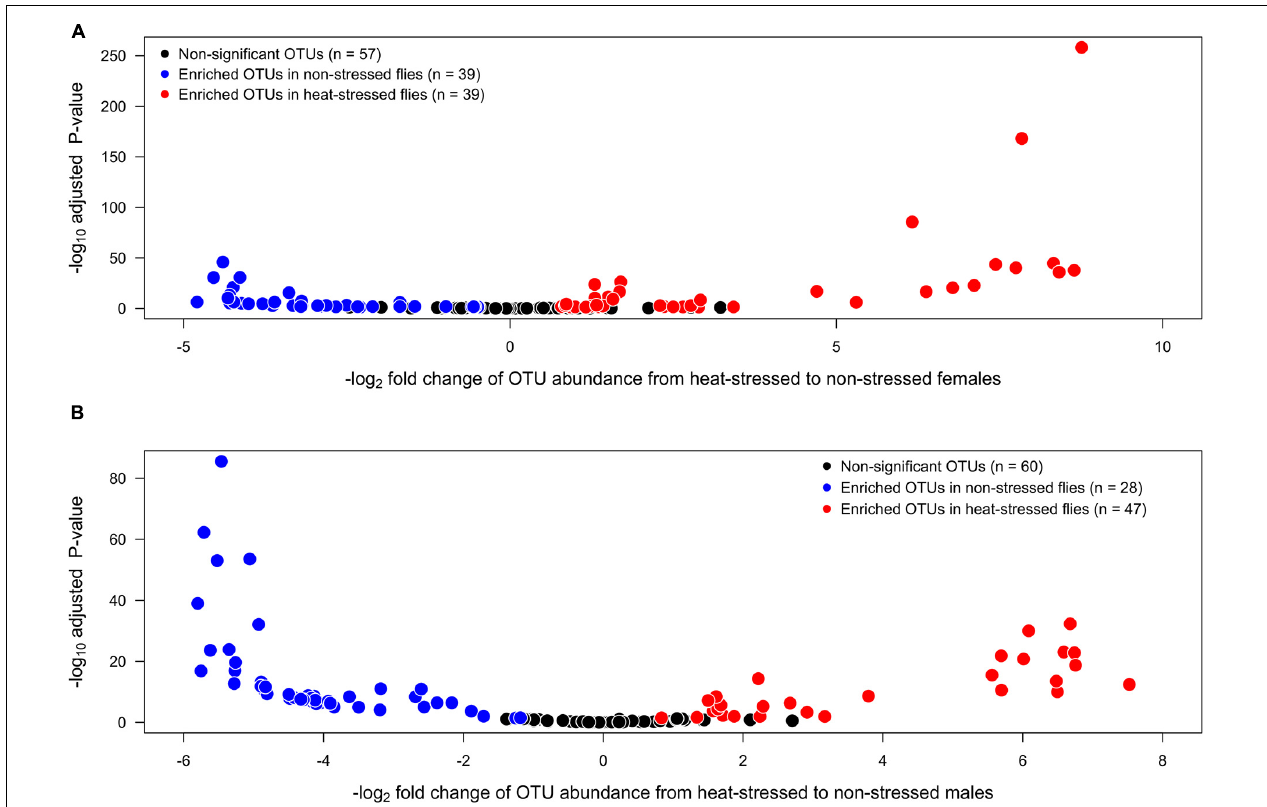
FIGURE 3 | Volcano plots illustrating the bacterial operational taxonomic units (OTUs) that show significantly higher abundances in non-stressed (exposed to 21 ◦ C, blue circles) or heat-stressed (exposed to 34 ◦ C, red circles) flies for each sex: (A) females and (B) males of Drosophila subobscura . OTUs that exhibit similar abundances in non-stressed and heat-stressed flies are represented by black circles.